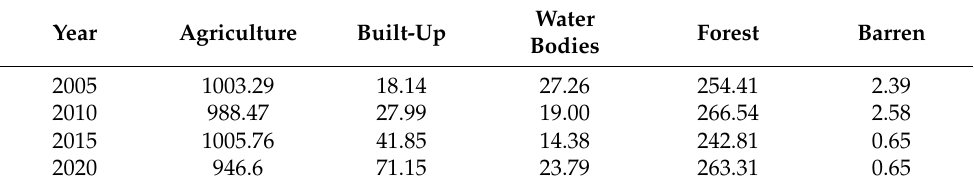
Table 4. Area (in sq. km.) of the different land cover classes for different years.